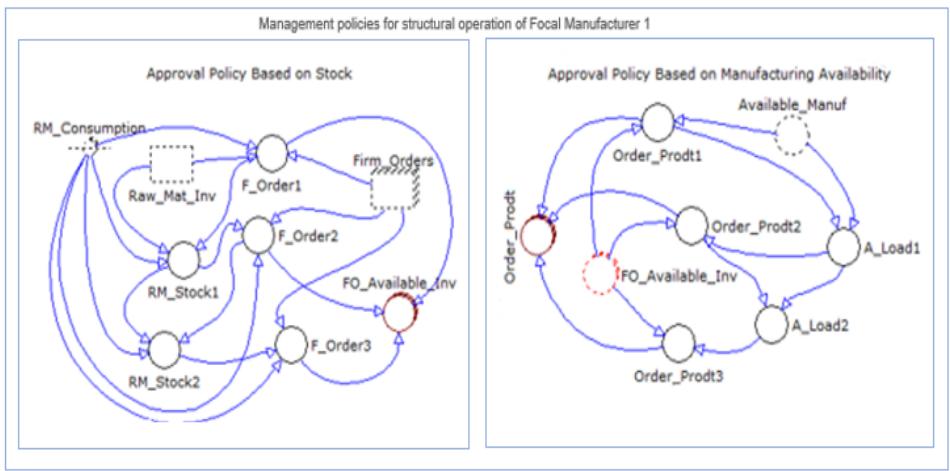
Figure 15. The structural operating policy of focal manufacturer 1. Source: own elaboration. Evolu- tion software.